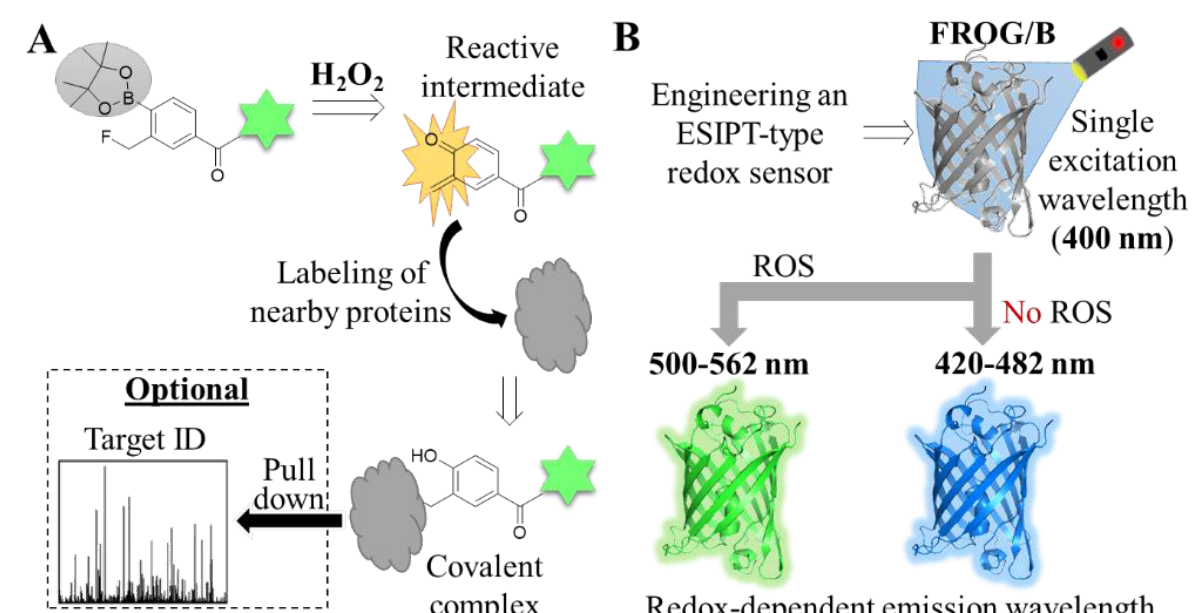
Figure 5. Tools for detecting H 2 O 2 . ( A ) Structure and mechanism of H 2 O 2 -responsive protein labeling using Hyp-L. A fluorescently labeled (indicated as a green star) small molecule probe with a H 2 O 2 -labile group (gray circle) forms a reactive intermediate upon oxidation, which is in turn inserted onto proximal proteins. The proteins can be visualized by fluorescent microscopy or subjected to proteomics workflow for identification. ( B ) Mechanism of the excitation state intramolecular proton transfer (ESIPT)-based protein reporter. A GFP was engineered to develop an ESIPT-based protein reporter (FROG/B). The final variant is excited by a single wavelength, but the emission wavelength can change depending on the presence or absence of ROS.